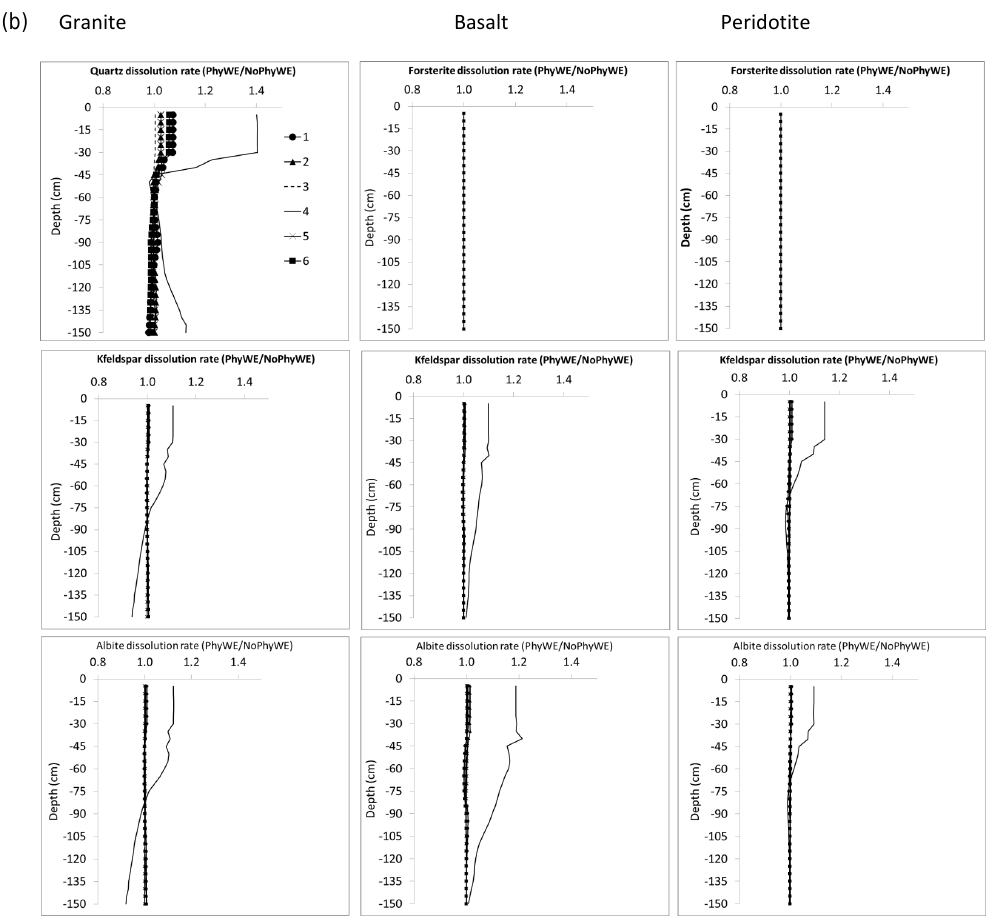
Figure 6. (b) Integrated effect of soil-forming processes on silicate mineral dissolution rates (Model B). Dissolution rates are presented here as a ratio of physical weathering to no physical weathering (i.e., PhyWE/NoPhyWE). Values greater than one imply that the rates are higher when physical weathering is allowed. Roman numerals 1–6 represent texture numbers presented in Table